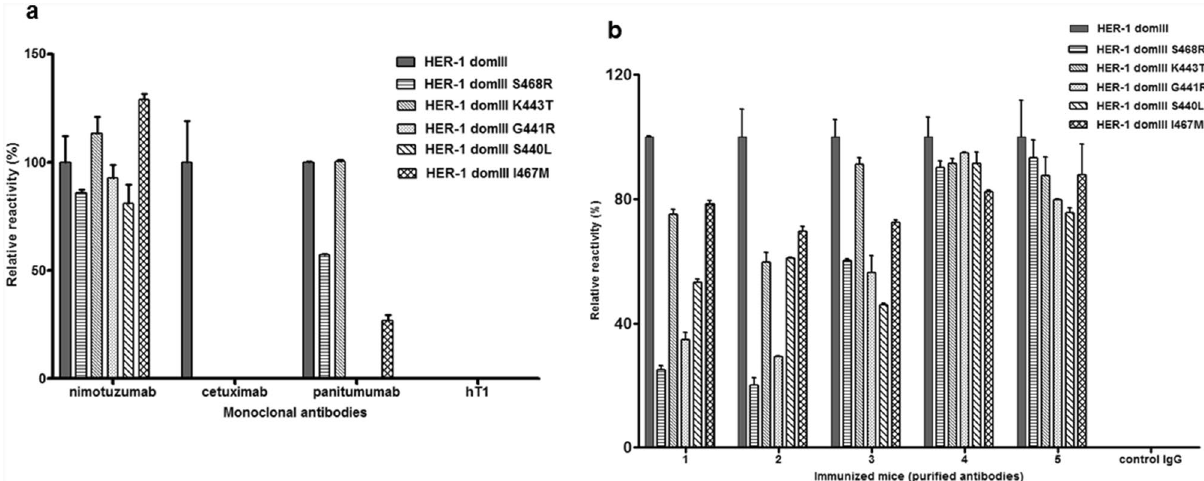
Figure 5. Reactivity of monoclonal and polyclonal antibodies against clinically relevant mutated variants of domain III of HER-1 conferring cetuximab treatment resistance. Recognition of phage-displayed domain III variants by monoclonal antibodies ( a ) and pooled polyclonal purified antibodies from HER-1 immunized mice ( b ) was evaluated through phage ELISA. The original phage-displayed HER-1 domain III and its mutated variants were incubated on microtiter plates coated with the different antibodies. Bound phages were detected with an anti-M13 mAb labeled with horseradish peroxidase. hT1 mAb and immunoglobulins from non- immunized mice (control IgG) were used as negative